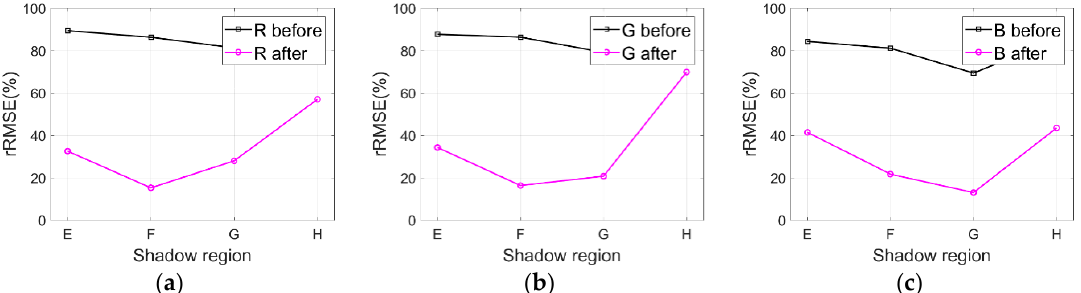
Figure 15. rRMSE of various shadow areas of images compensated before and after by the IRB approach for the test image Tripoli-2 in terms of R, G, and B components. ( a ) R. ( b ) G. ( c ) B .